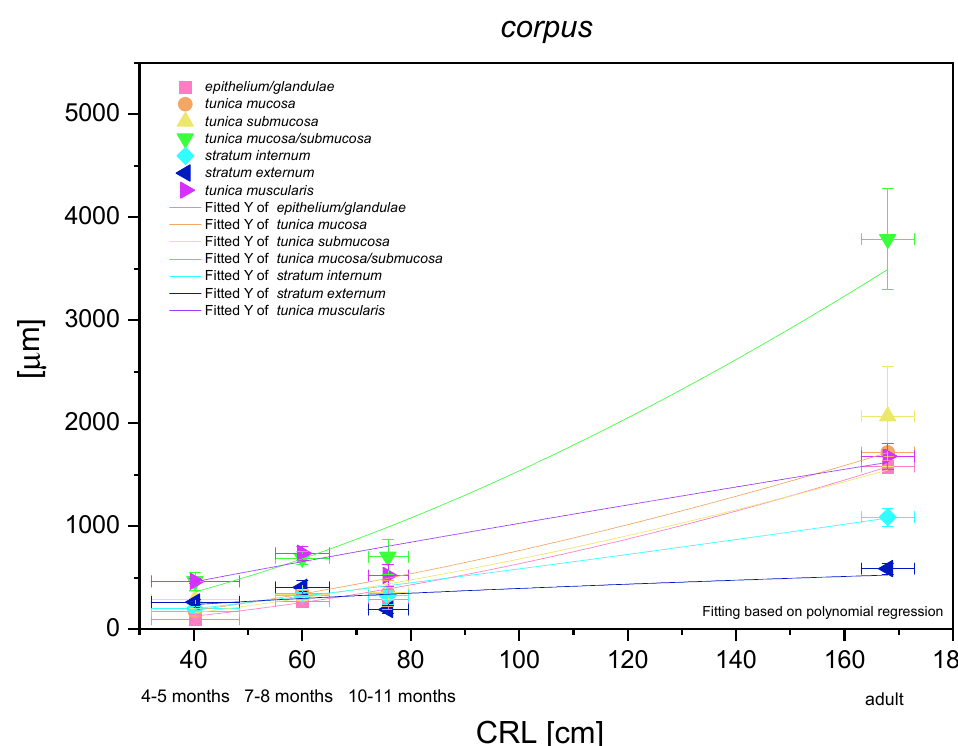
Figure 16. Histometric analysis of the stomach wall structures in the body of the stomach (corpus). The figure shows nonlinear and exponential regression curves of all metric parameters in all three age groups and the adult reference